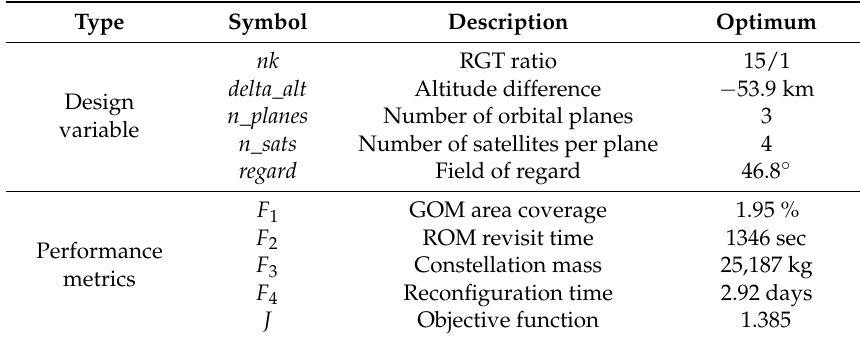
Figure 13. GA convergence history: ( a ) Population mean; ( b ) best individual. Table 16. GA optimal solution (3 planes).